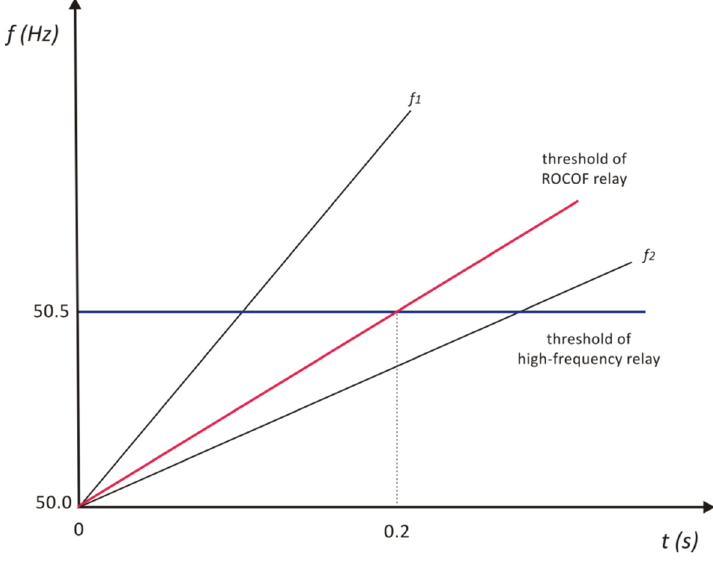
Figure A1. Threshold setting of the high-frequency and ROCOF relays for rotating